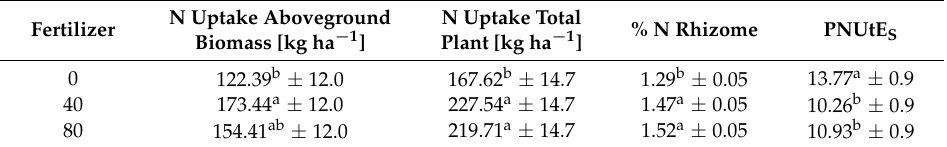
Table A3. Results of a multiple t-test at significance level of 5% after finding significant differences via global F-test for the factor fertilizer (0, 40 and 80 kg N ha − 1 ). Same lowercase letters indicate no significant differences between the fertilization levels.